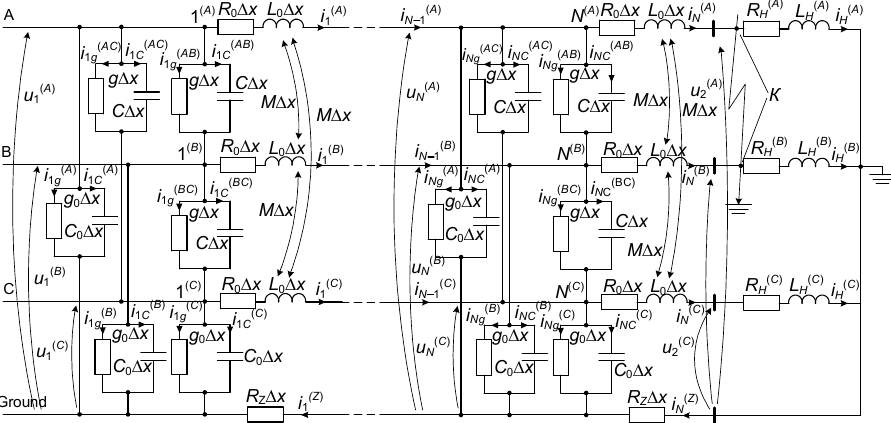
Figure 1. Calculation scheme of the studied fragment of the electrical network (for the first and last discrete sections of the line).